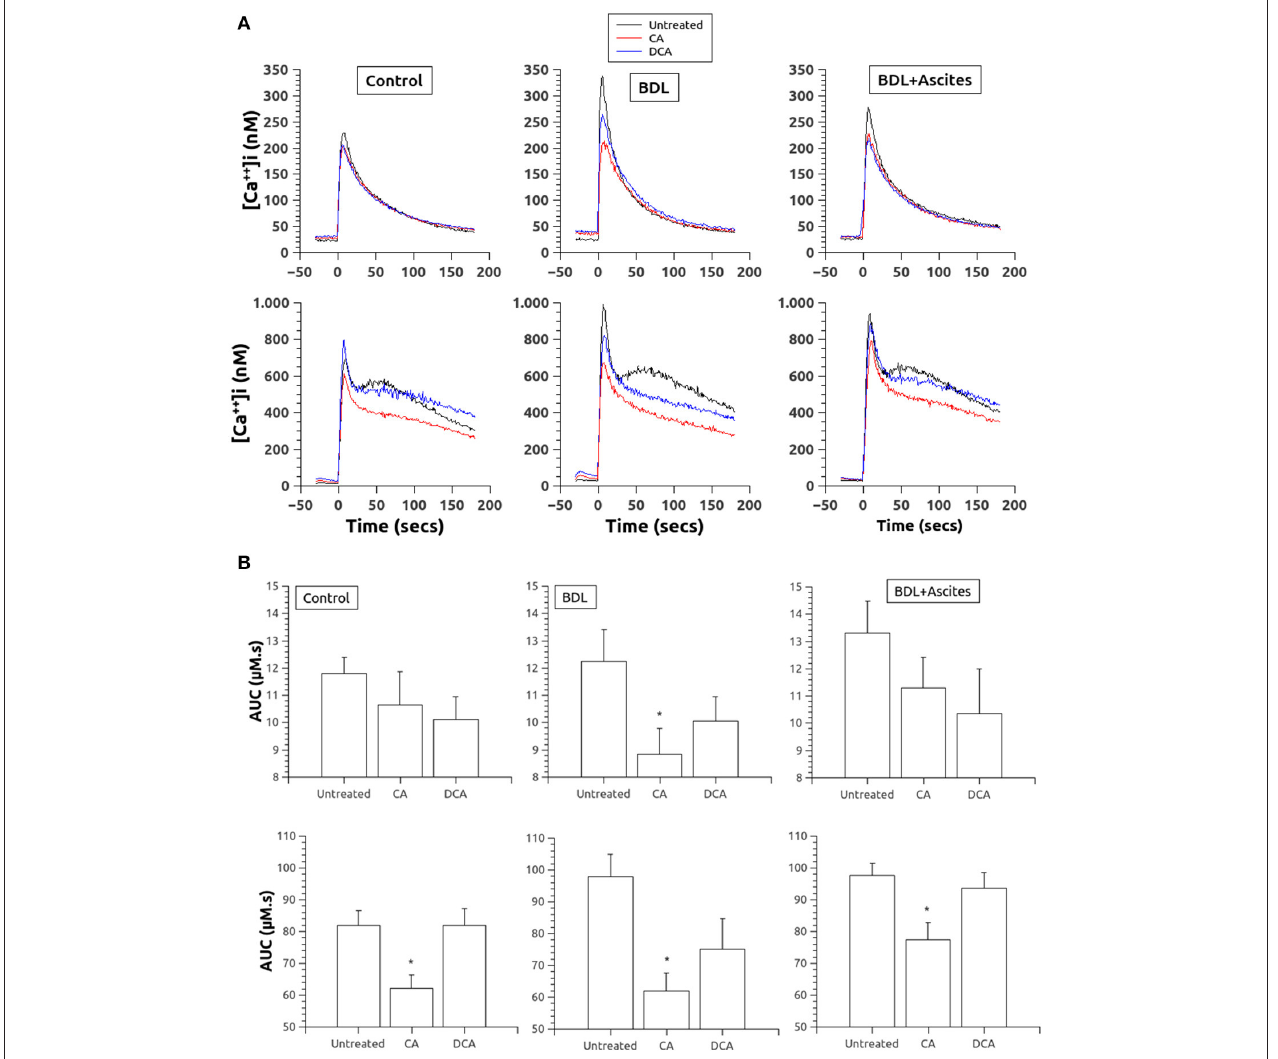
FIGURE 1 | (A) Changes in [Ca 2 + ] i in platelets of control (left column), BDL (middle column) and BDL with ascites rats (right column) in response to thrombin (0.3 U/ml, added at time 0). Top, in the absence of extracellular Ca 2 + . Bottom, in the presence of extracellular Ca 2 + . Data were obtained in untreated platelets and after incubation with CA or DCA (100 µ M each). (B) . Area under the curve of the calcium changes after thrombin administration (0.3 U/ml, added at time 0) in the absence (top panels) and in the presence (bottom panels) of extracellular Ca 2 + . Data were obtained in untreated platelets and after incubation with CA or DCA (100 µ M each). Results are means ± S.E.M. * p < 0.05 vs.